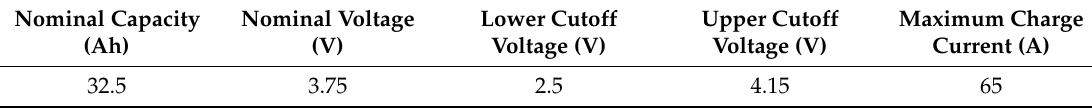
Table 1. Main parameters of the test